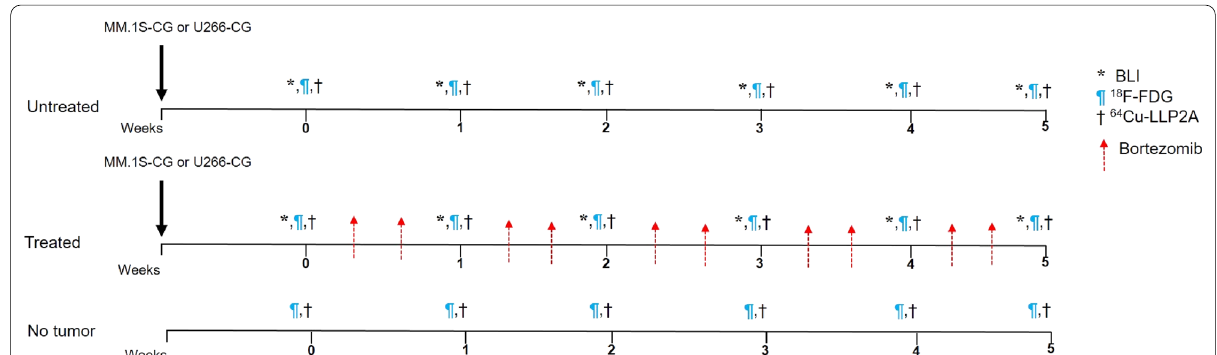
Fig. 1 Imaging and therapy study design. NOD-SCID Gamma (NSG) mice were injected with human myeloma cell lines, MM.1S-CG and U266-CG via tail vein. Tumor progression was monitored weekly by bioluminescence imaging (BLI). Mice were divided into three cohorts—tumor bearing untreated ( n 6), tumor bearing treated ( n 6) and no tumor healthy mice ( n 4). The treatment group was injected with bortezomib (1 mg/kg) = = = twice a week intraperitoneally starting at week 1 post-inoculation of MM.1S-CG and U266-CG cells, respectively. Mice were imaged weekly with small animal [ 18 F]FDG PET and [ 64 Cu]Cu-LLP2A PET,